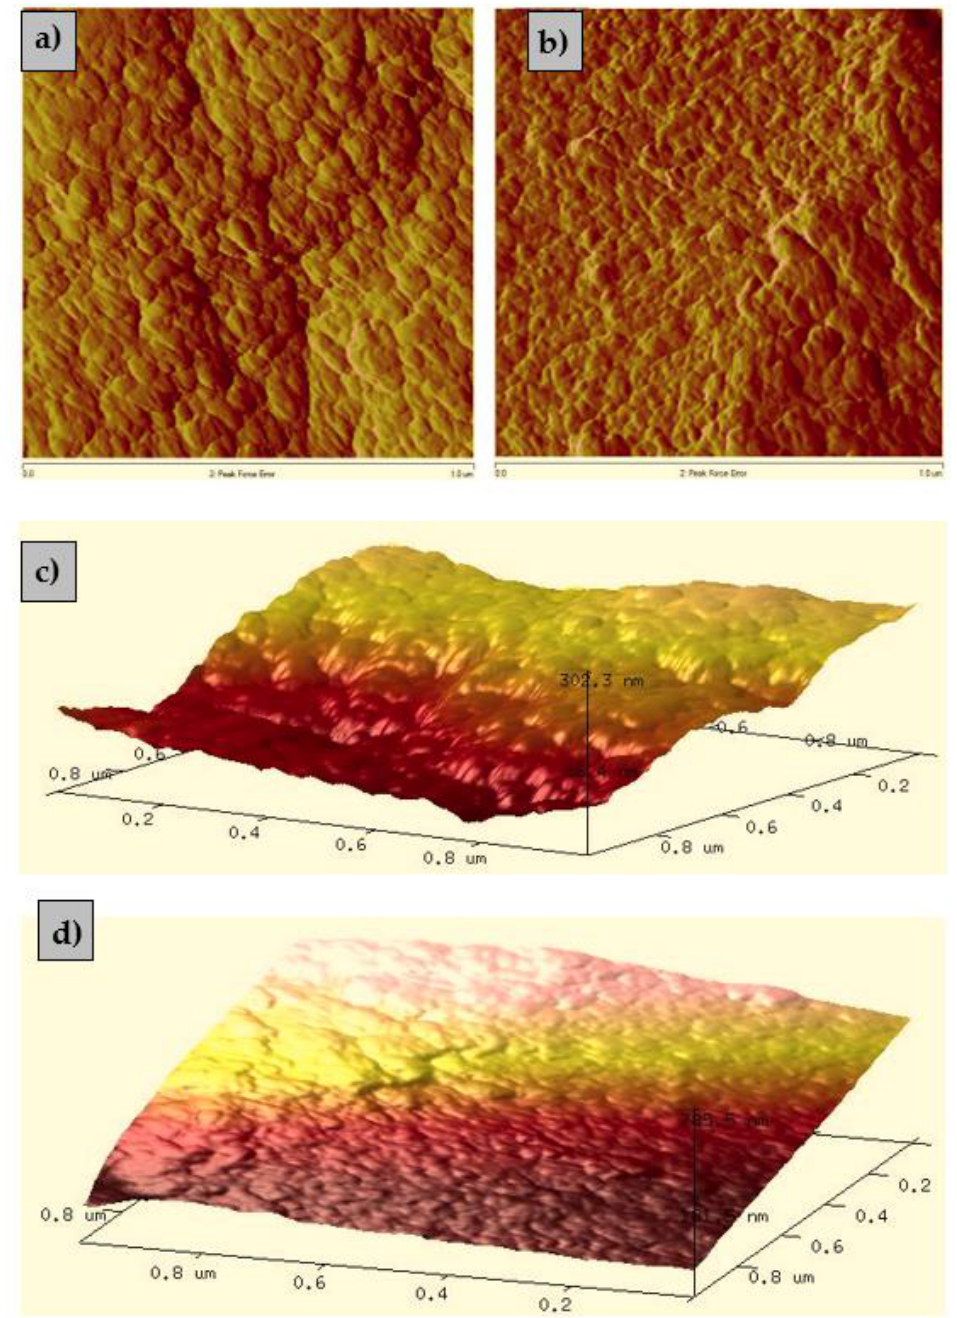
Figure 3. ( a , b ) 2D and ( c , d ) 3D AFM images before and after the La(III) ions sorption on the ALG 5 L 1 composite.